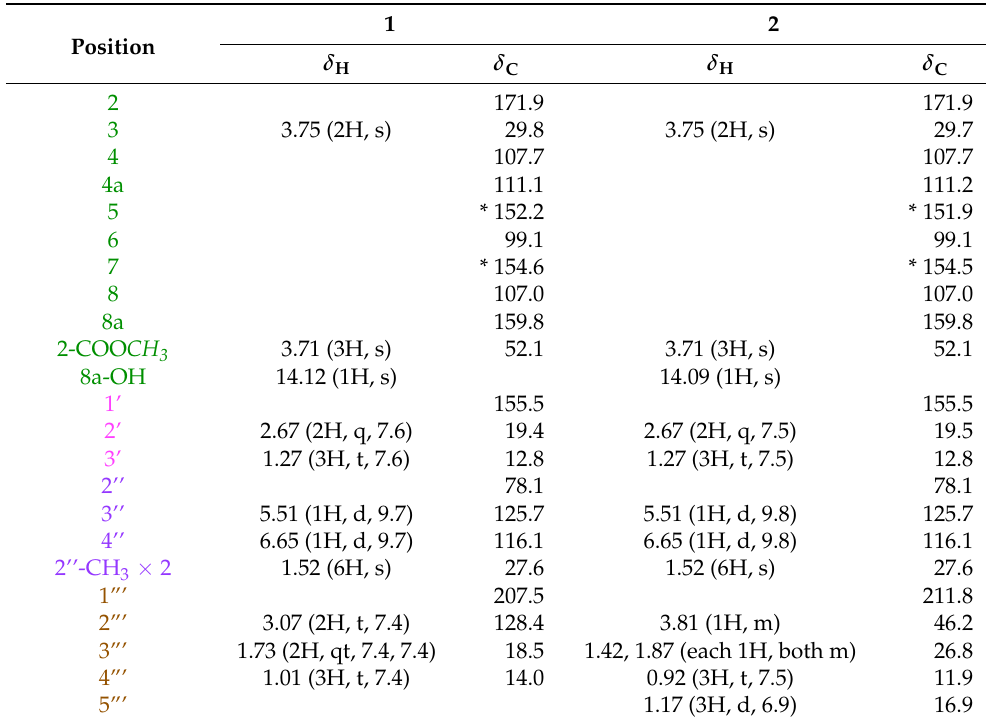
Table 2. 1 H and 13 C NMR spectroscopic data (500 and 125 MHz, CDCl 3 ) of mammeasins P ( 1 ) and Q ( 2 ).